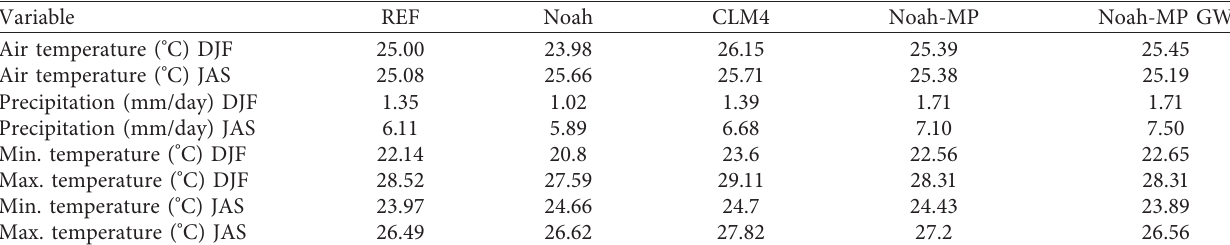
Table 2: Average reference and simulations for temperature and